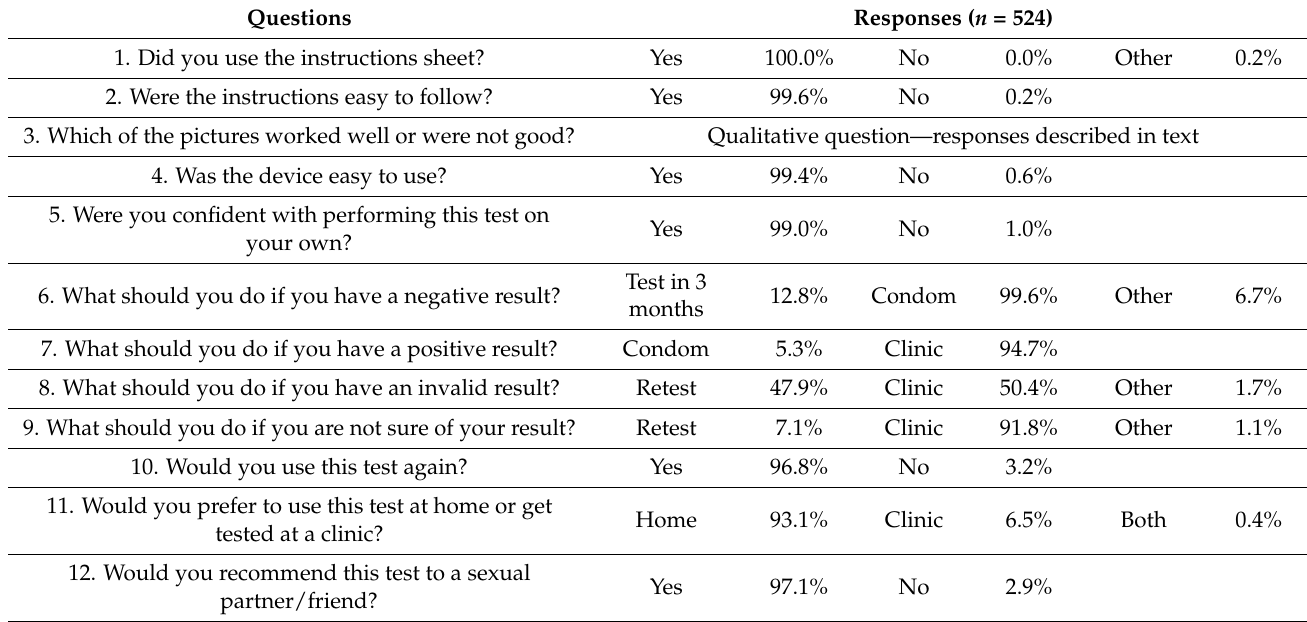
Table 6. Post-Test